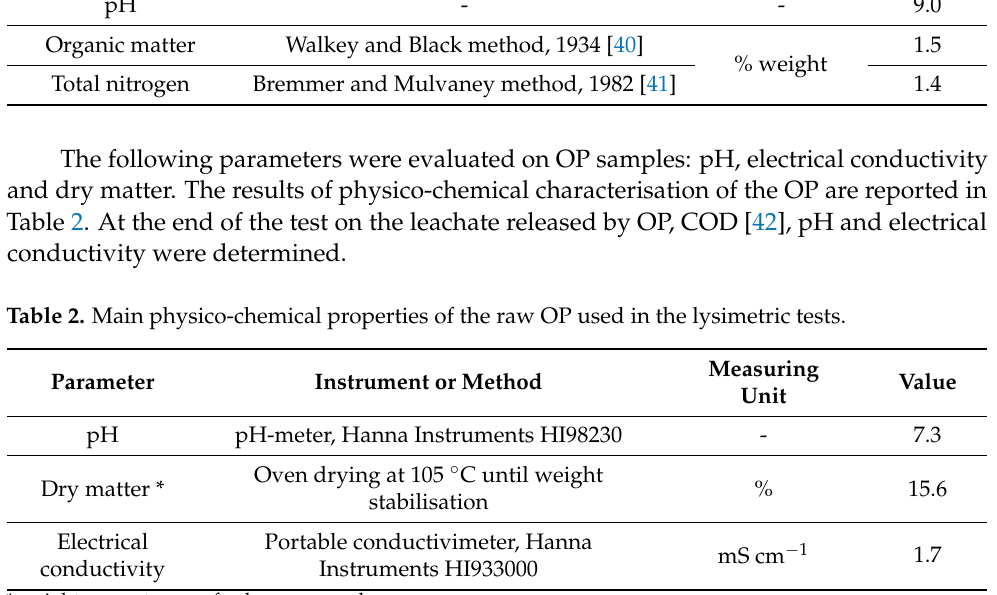
Table 1. Main physico-chemical properties of the sandy loam soil used in the lysimetric tests. Parameter Method pH - - 9.0 Organic matter Walkey and Black method, 1934 [40] Total nitrogen